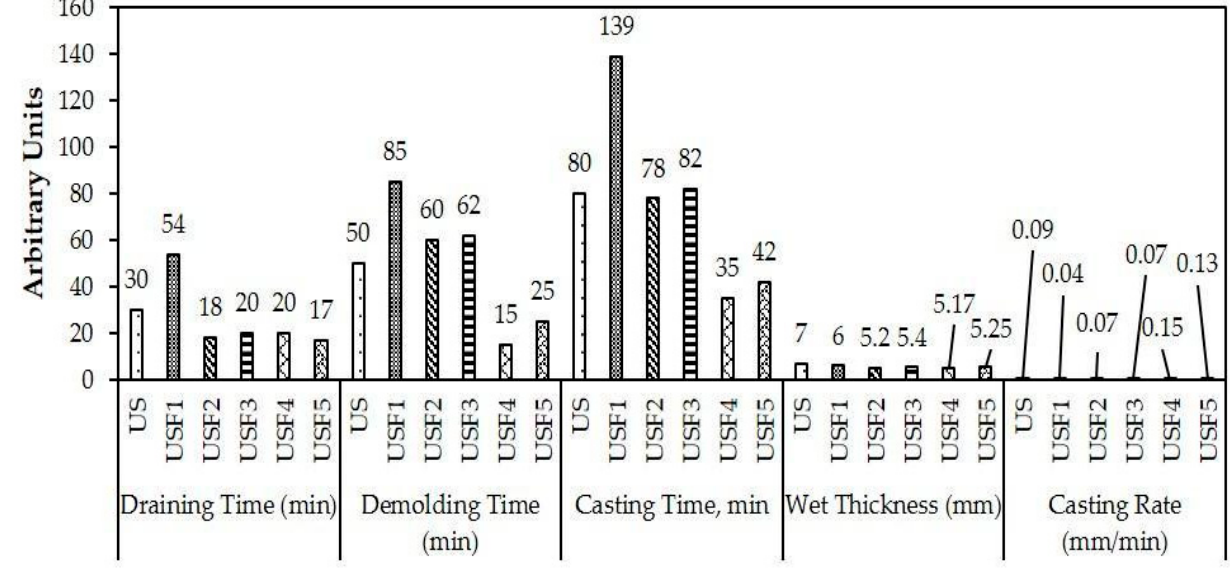
Figure 6. Comparison of casting properties of the different slip formulations .